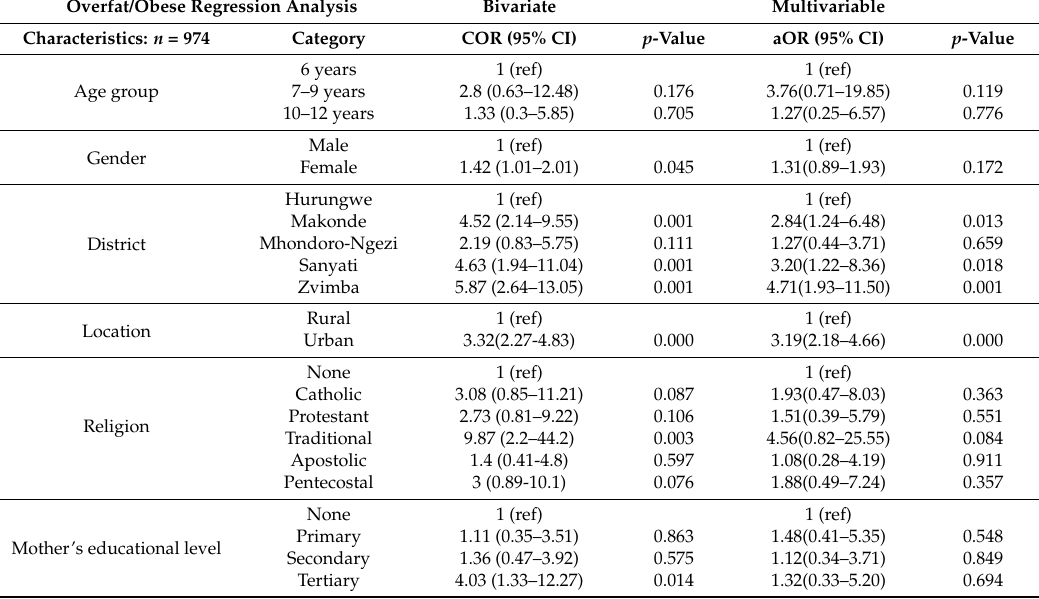
Table 3. Bivariate and multivariable regression analysis of primary school children demographics to analyze risk of overfat/obese, defined from Bioelectrical Impedance measures with the McCarthy et al. 2006 body fat-for-age reference [38]. Bivariate